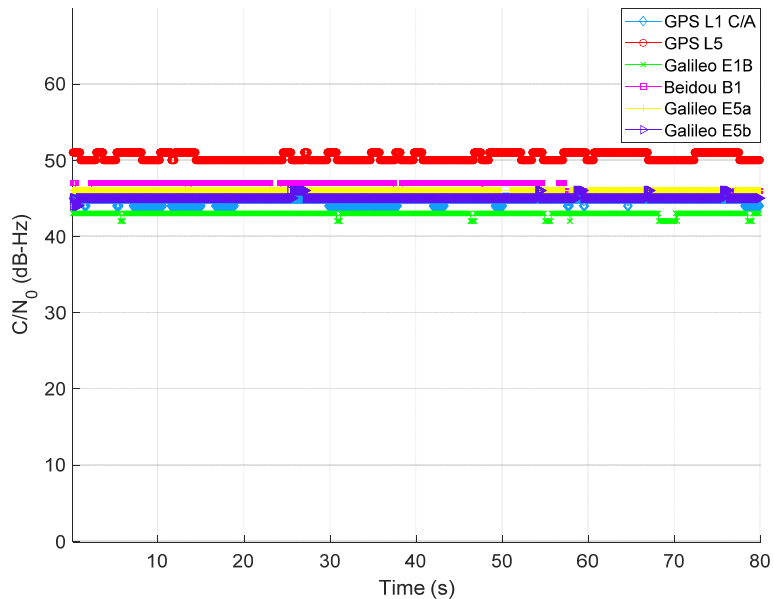
Figure 6. Average C/N (cid:2868) of tracked GNSS signals without the presence of intentional jamming.